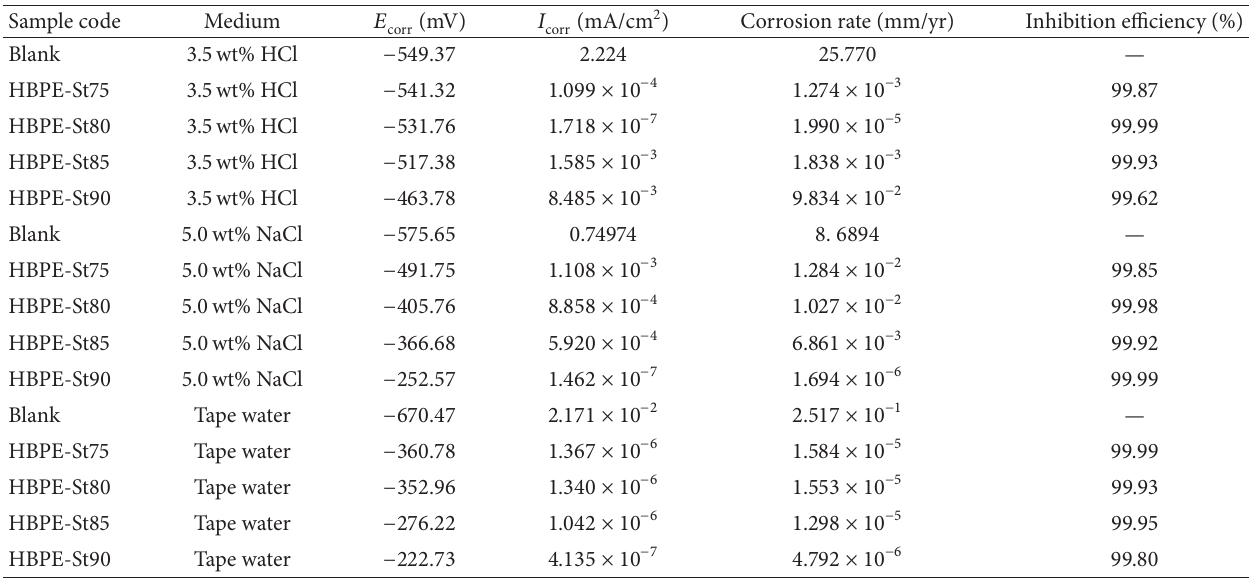
Table 2: Corrosion parameter for coated and blank mild strips in different corrosive environments.